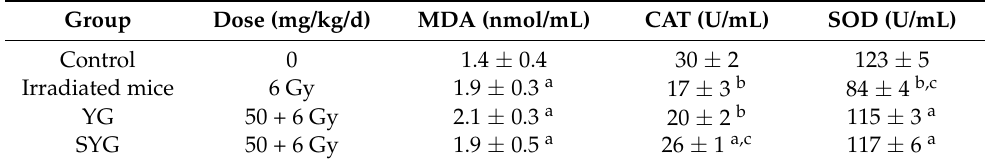
Table 5. Effects on activities of SOD, CAT and MDA in spleen of mice radiated with 60 Co ( n = 6). Group Dose (mg/kg/d) MDA (nmol/mL) CAT (U/mL) SOD (U/mL) Control 0 1.4 ± 0.4 30 ± 2 123 ± 5 Irradiated mice 6